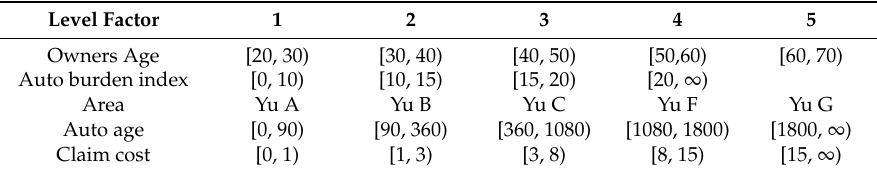
Table 4. Rate factor grading table (Yu represents Chongqing in China).